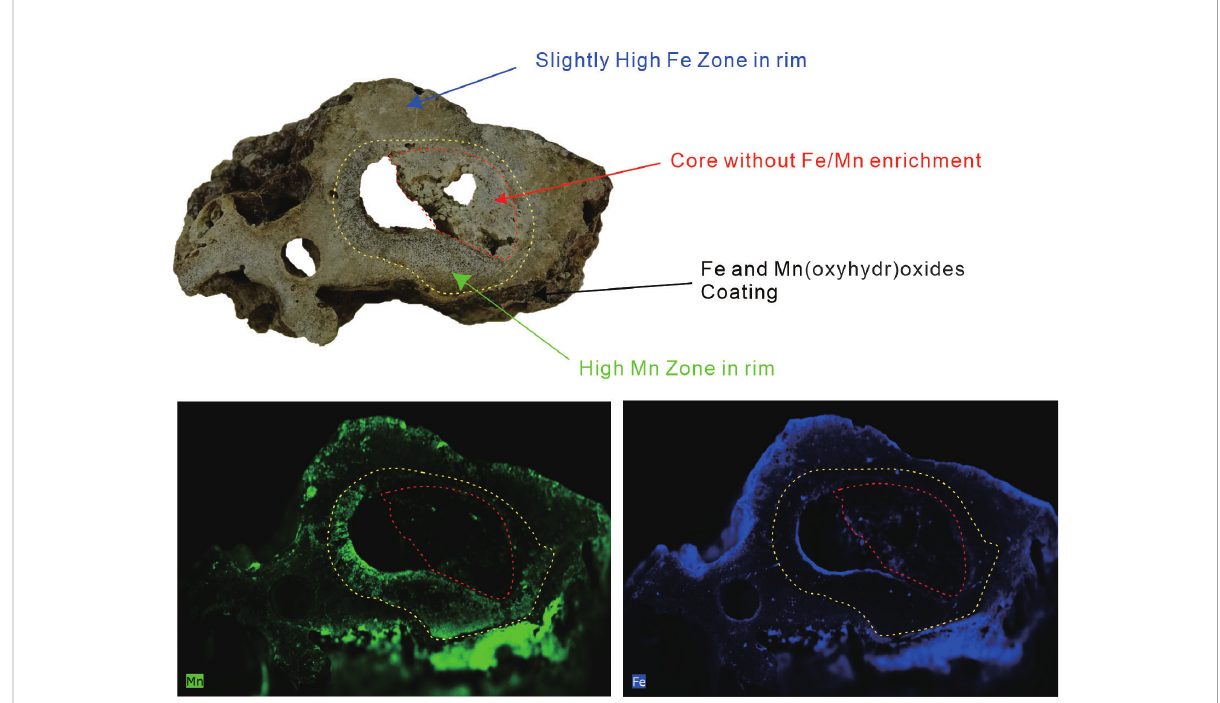
FIGURE 8 Fe and Mn scanning map of sample R3 obtained by high-resolution X-ray fl uorescence ( m XRF). The upper photograph shows the distribution of Fe/Mn elements on the fresh surface of the hand specimen. The bottom photographs show the scanning results of Mn (bottom left) and Fe (bottom right) elements on the fresh surface. The zoned distribution of Fe and Mn content is recognized (yellow dashed line). The coating on the outer and inner surfaces of the carbonates reveals both high Fe and Mn content. The core (red dashed line) does not reveal obvious Fe or Mn